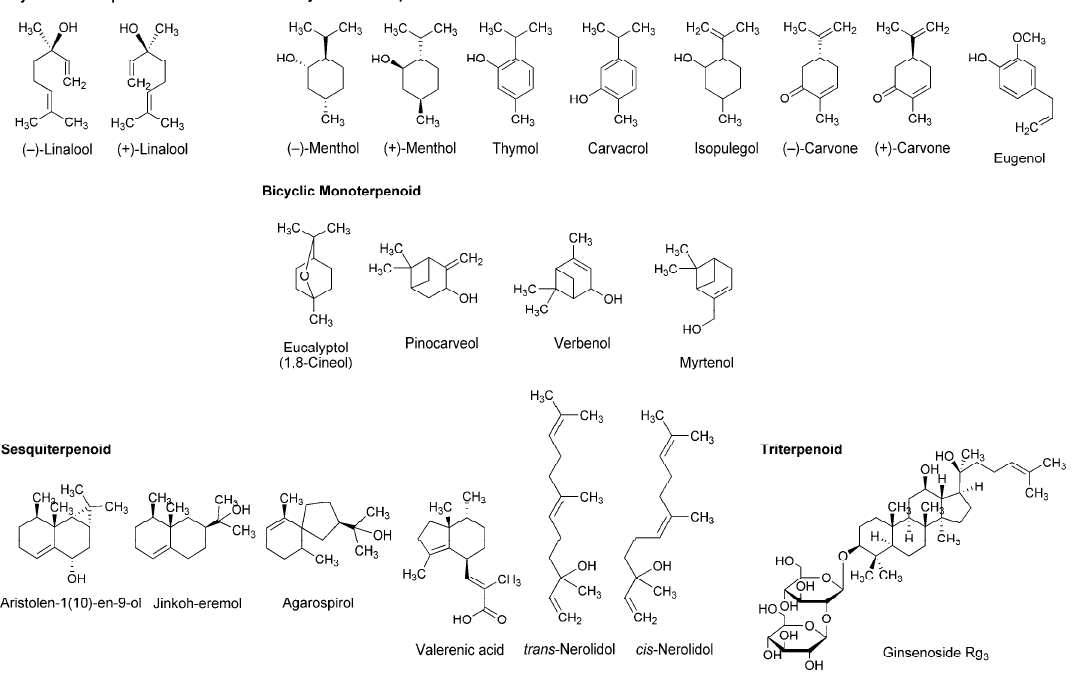
Figure 6. Terpenoids with the general anesthetic activity.